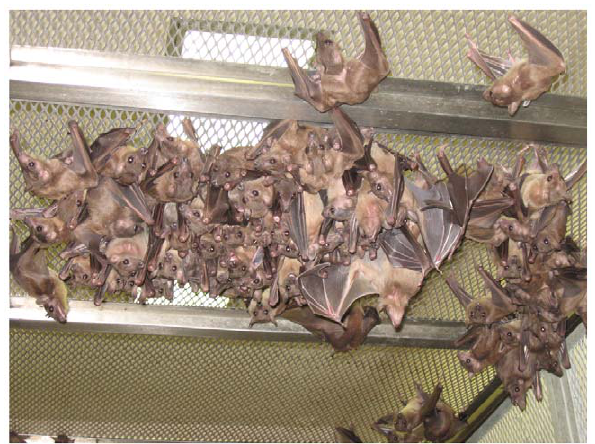
Figure 1. R.aegyptiacus colony maintained in large flight cage allowing for housing 150–200 bats.